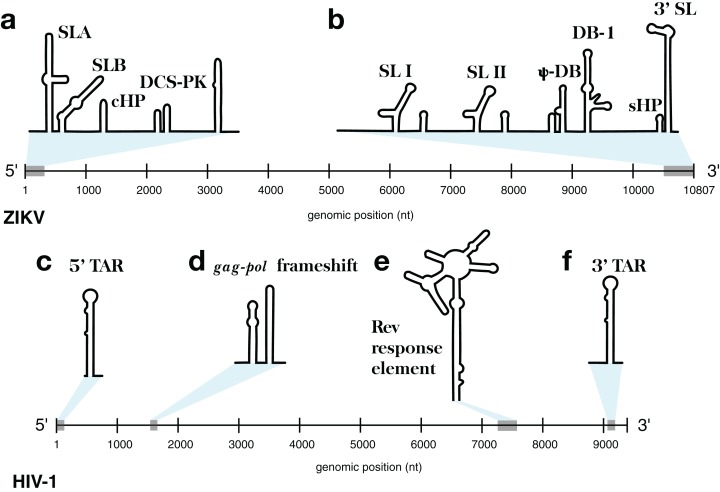
Models of the known functional RNA structural motifs found in the 5′ and 3′ end regions of the ZIKV genome and throughout the genome of HIV-1.(A) Structure model of the 5′ UTR region as shown in Ye et al. (2016). (B) Structure model of the 3′ UTR region as shown in Goertz et al. (2017). The four main RNA structural motifs of HIV-1 described in Watts et al. (2009) are shown as well: (C) the 5′TAR element; (D) the gag-pol frameshift element; (E) the RRE; and (F) the 3′TAR element. The relative genomic location of all structures is shown on a number line the length of its respective genome of origin.